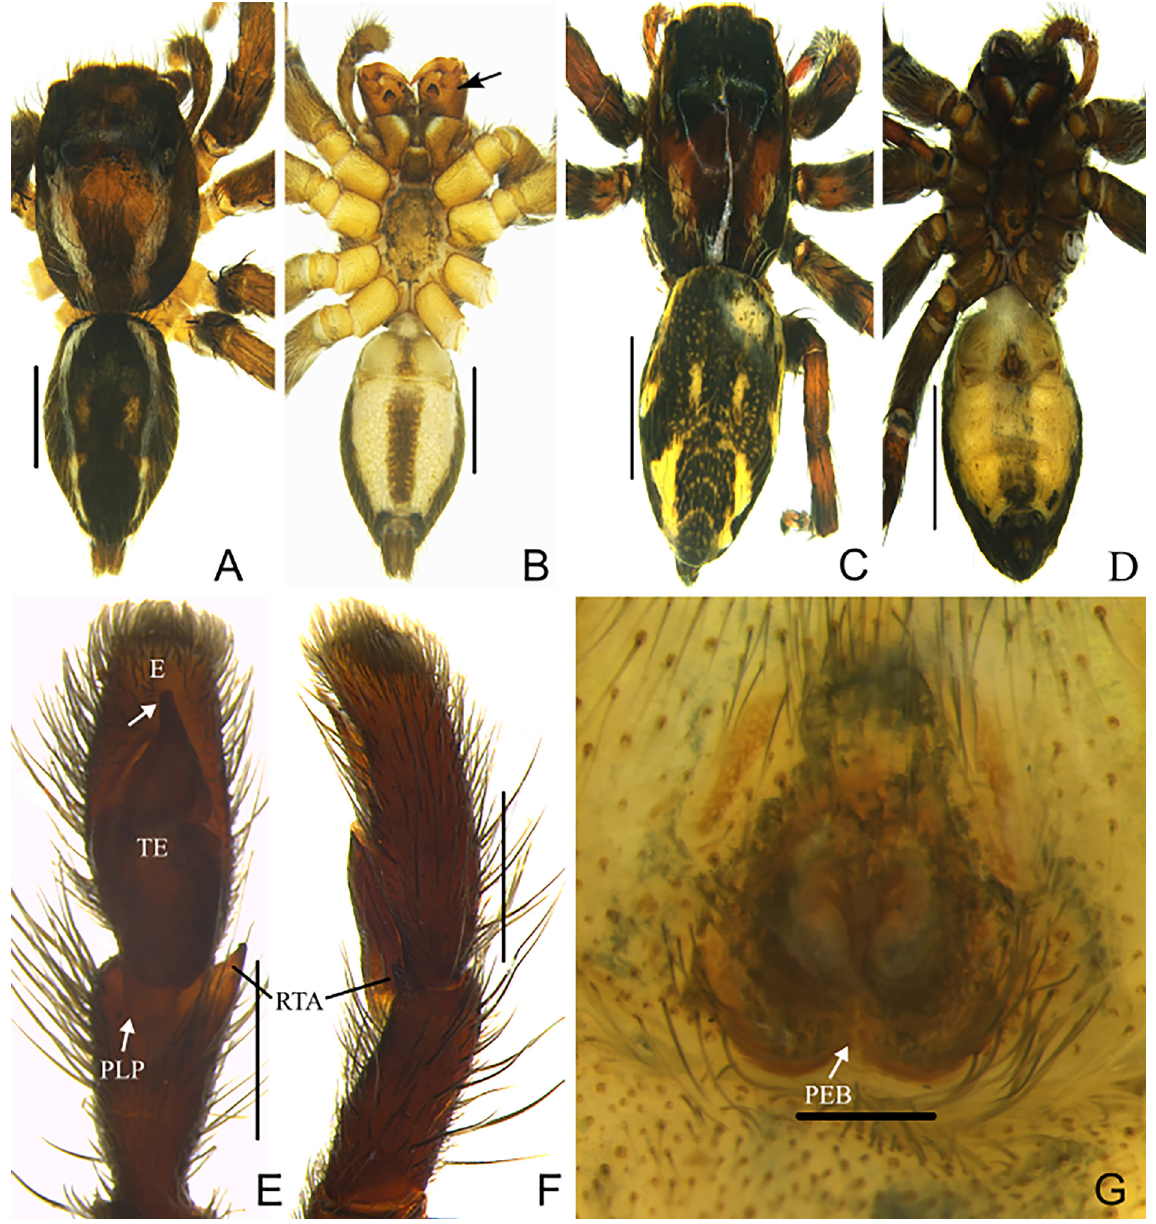
Fig 15 . Carrhotus viduus (C.L. Koch, 1846). A–B . Male habitus. A . Dorsal view. B . Ventral view. C–D . Female habitus. C . Dorsal view. D . Ventral view. E–F . Palp. E . Ventral view. F . Retrolateral view. G . Epigynum, ventral view. Abbreviations: E = embolus; PEB = posterior epigynal border; PLP = posterior lateral protrusion; RTA = retrolateral tibial apophysis; TE = tegulum. Scale bars: A–D = 2 mm; E–F = 0.2 mm; G = 0.1